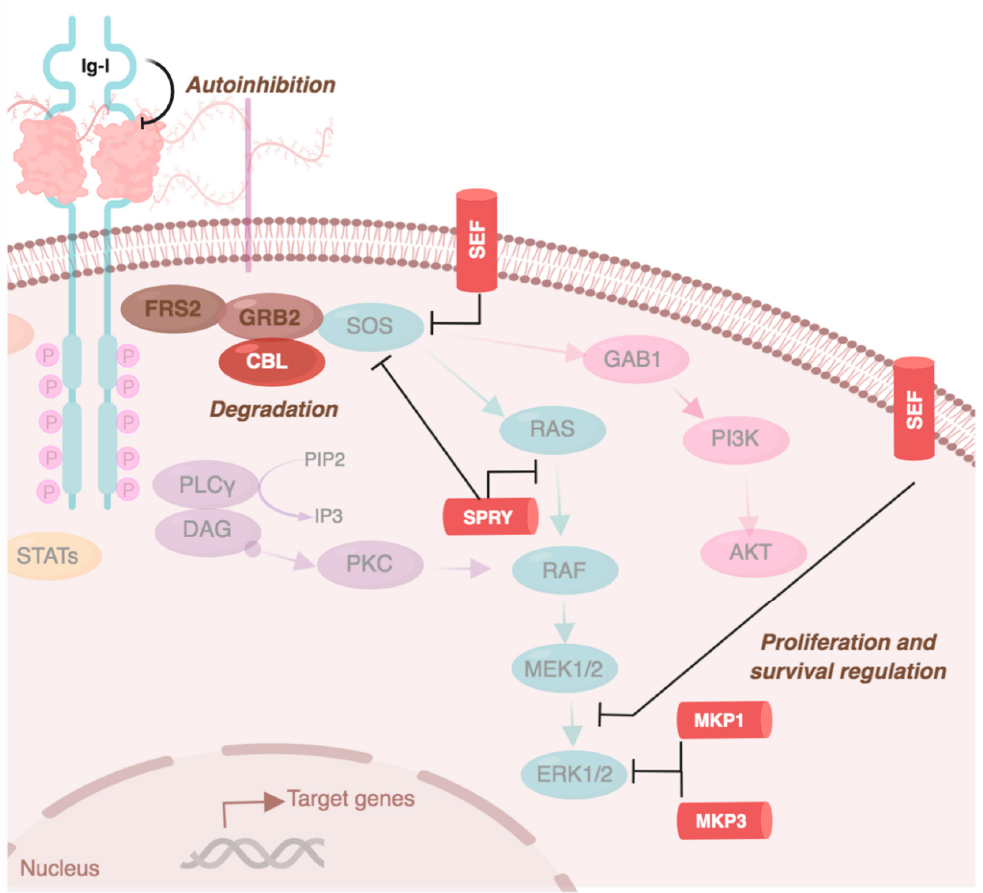
Figure 4. FGFR signaling pathway regulation. FGFR signaling is negatively regulated, partly by CBL (inducing FGFR degradation after receptor internalization), by SEF, SPRY, MKP1, and MPK3 (which